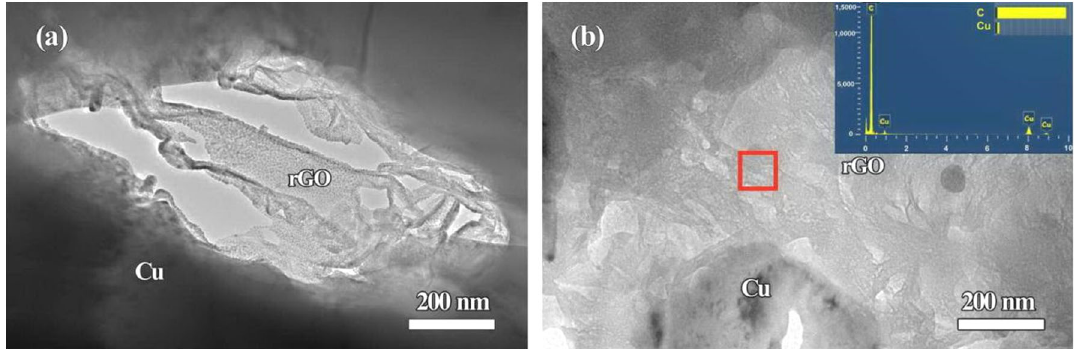
Figure 8. TEM images of rGO nanosheets in the sintered compacts 1rGO ( a ) and 3rGO ( b ) samples. The inset shows EDS result of rGO nanosheets.